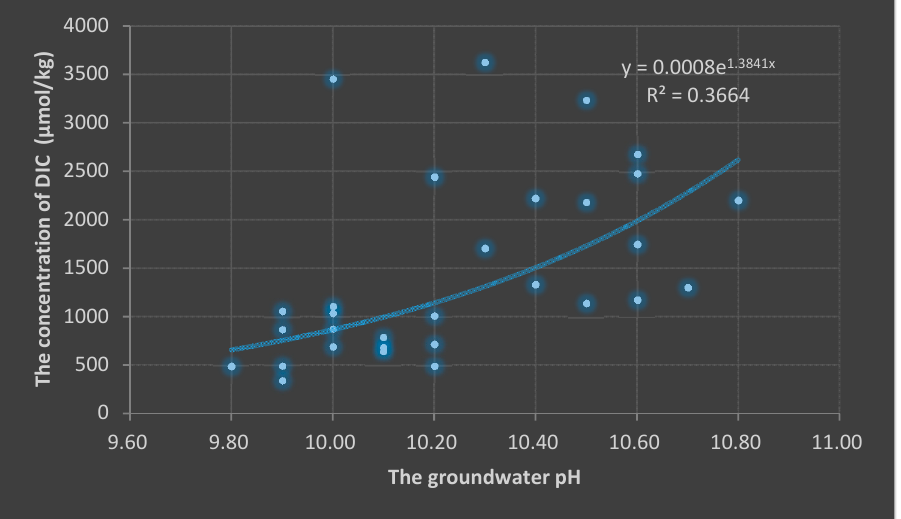
Figure 10. The relationship between the groundwater pH and the concentration of dissolved inorganic carbon (DIC) in the artificial soil ‐ groundwater system.